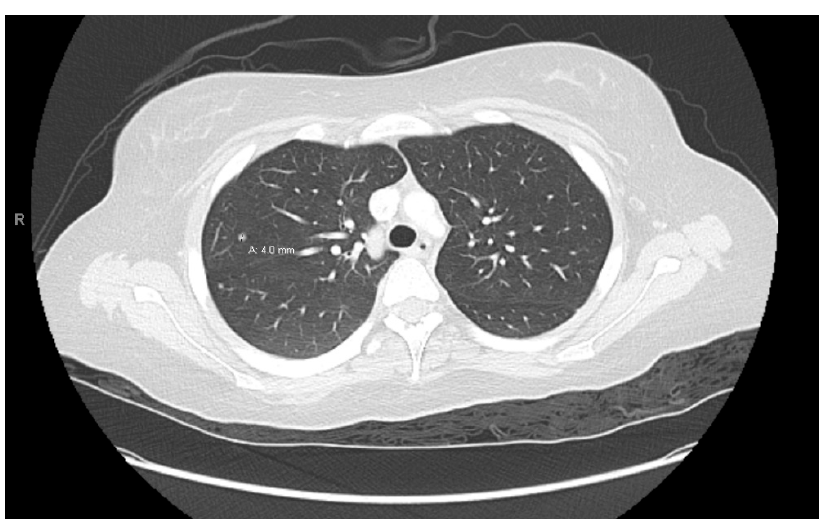
Figure 4. Right renal tumor.